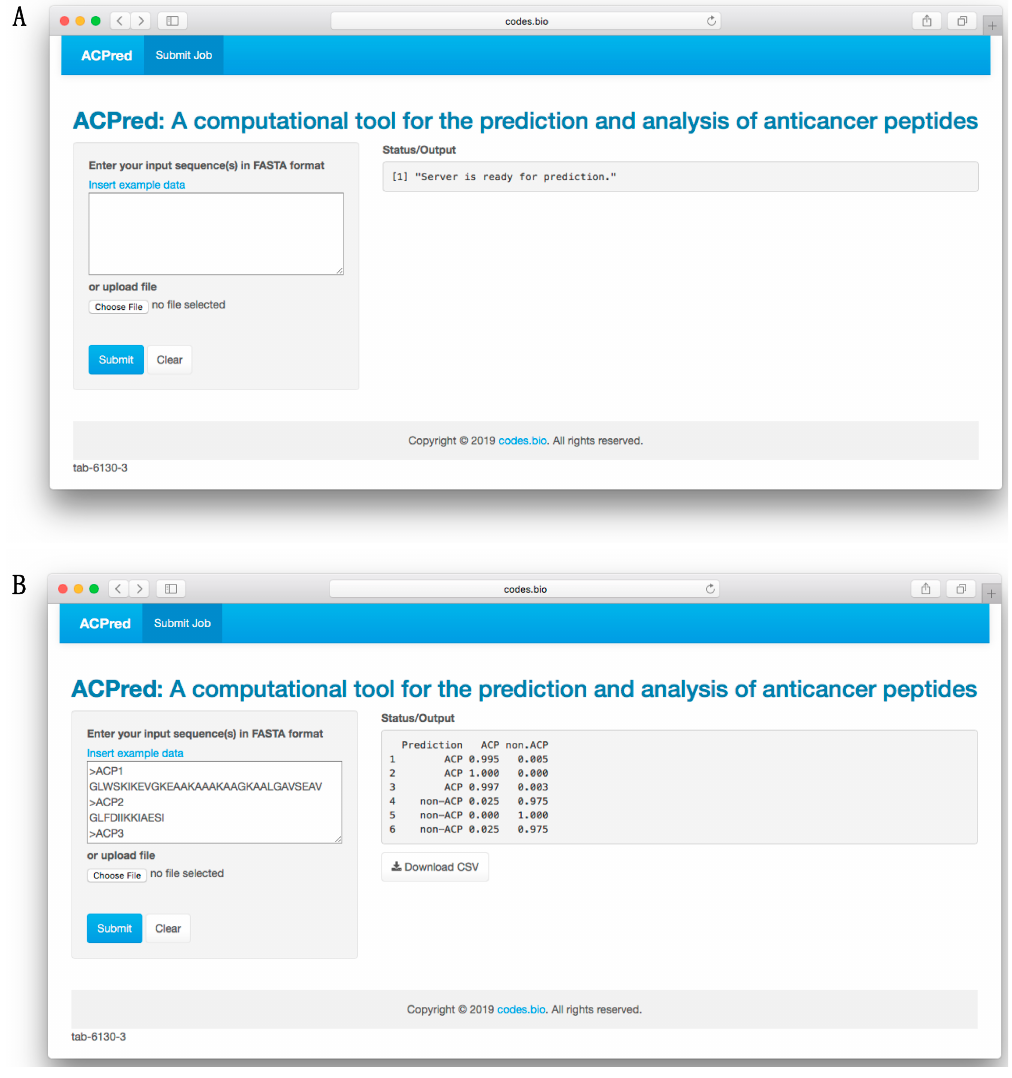
Figure 5. Screenshots of the ACPred web server before ( A ) and after ( B ) submission of sequence data for prediction.